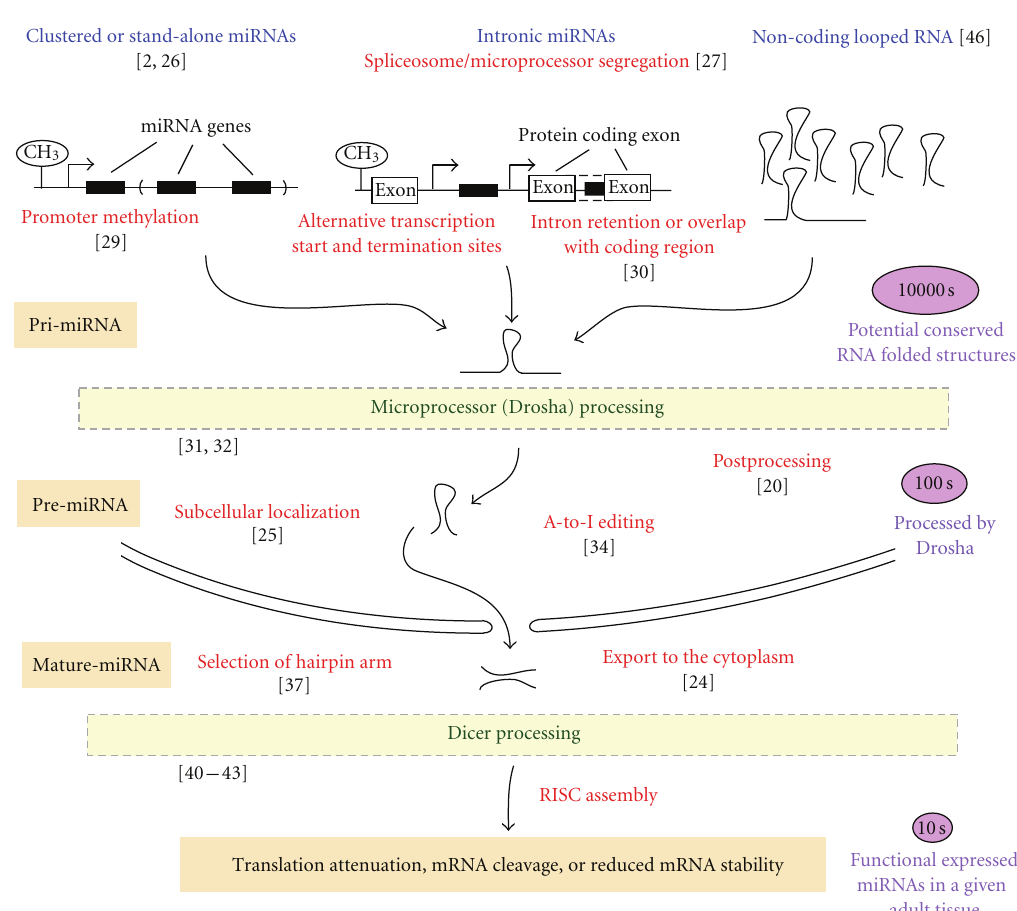
Figure 1: Several layers of regulation control canonical miRNA gene biogenesis: transcription activation, splicing, recognition by Drosha, postprocessing, RNA editing, subcellular localization, nuclear export, and hairpin arm selection. Selected examples are referenced